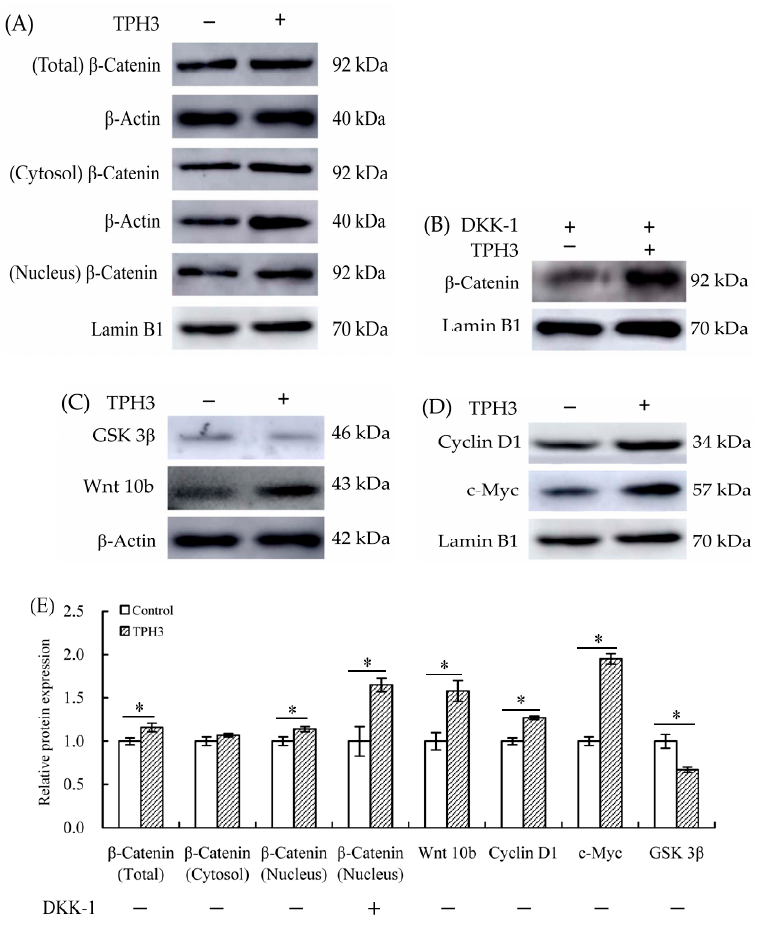
Figure 8. Expression changes of the proteins related to Wnt/ β -catenin pathway in the osteoblasts. The cells were exposed to vehicle, TPH3 (0.05 g/L) for 48 h ( A , C , D ), and DKK-1 (100 ng/mL) in the absence or presence of TPH3 (0.05 g/L) for 48 h ( B ). Relative protein expression was normalized against β -actin in total cellular or cytoplasmic protein, or against Lamin B1 in nuclear protein ( E ). *: compared to control, p < 0.05.